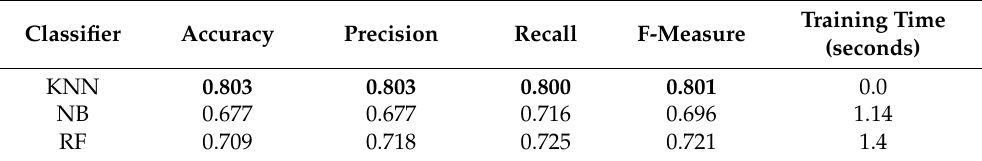
Table 8. Identification results of VGG-19-deep features obtained by maximizing (F6 and F7). Bold values signify the best performance.